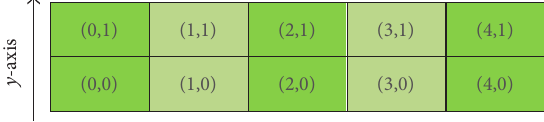
Figure 12: (5 × 2) tile map structure.